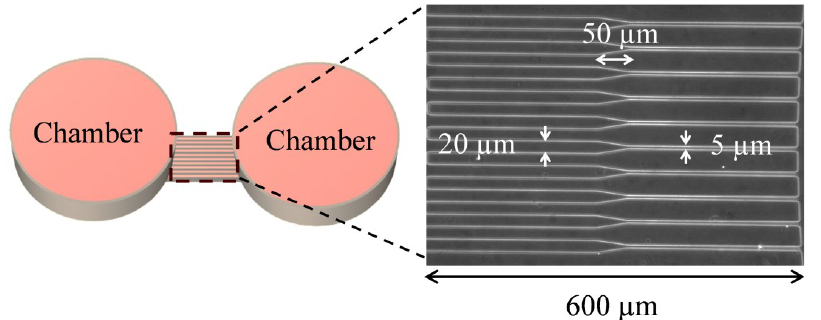
Figure 1. The design of the microfluidic device: The microfluidic device consists of two chambers connected with ten 600 µm-long and 10 µm-high microchannels. The channels taper from 20 µm to 5 µm over a transition length of 50 µm towards the center of the